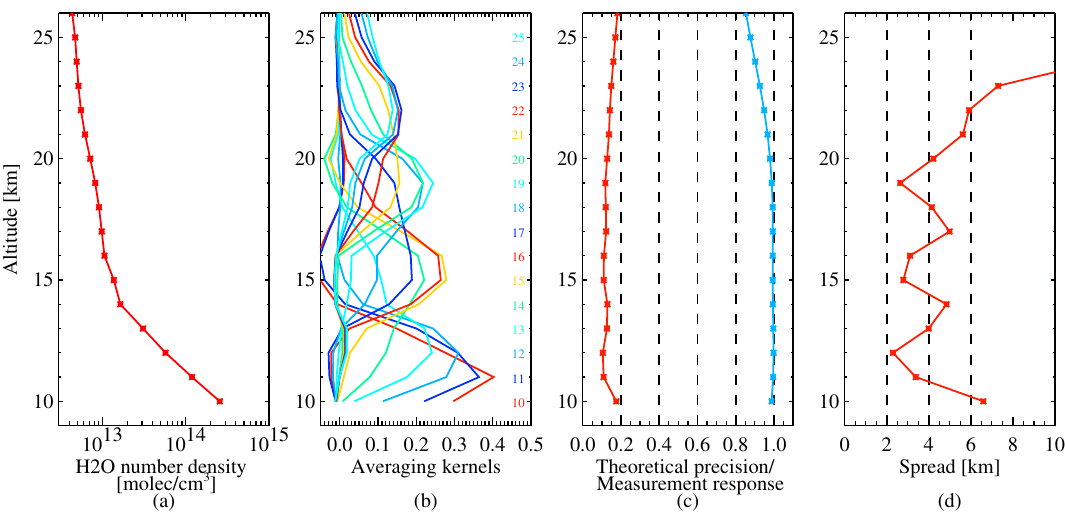
Fig. 7. Characterization of the water vapor retrieval for a typical observation in winter over Boulder, CO, USA: (a) vertical distribution of the water vapor number density measured by SCIAMACHY, (b) averaging kernels, (c) theoretical precision of the retrieval (red) and measurement response function (light blue), (d) spread of the averaging